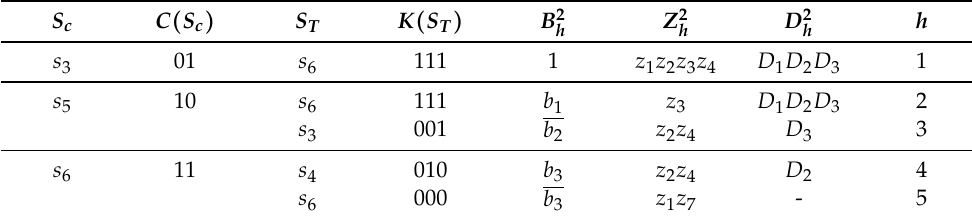
Table 4. Table of block LB2.